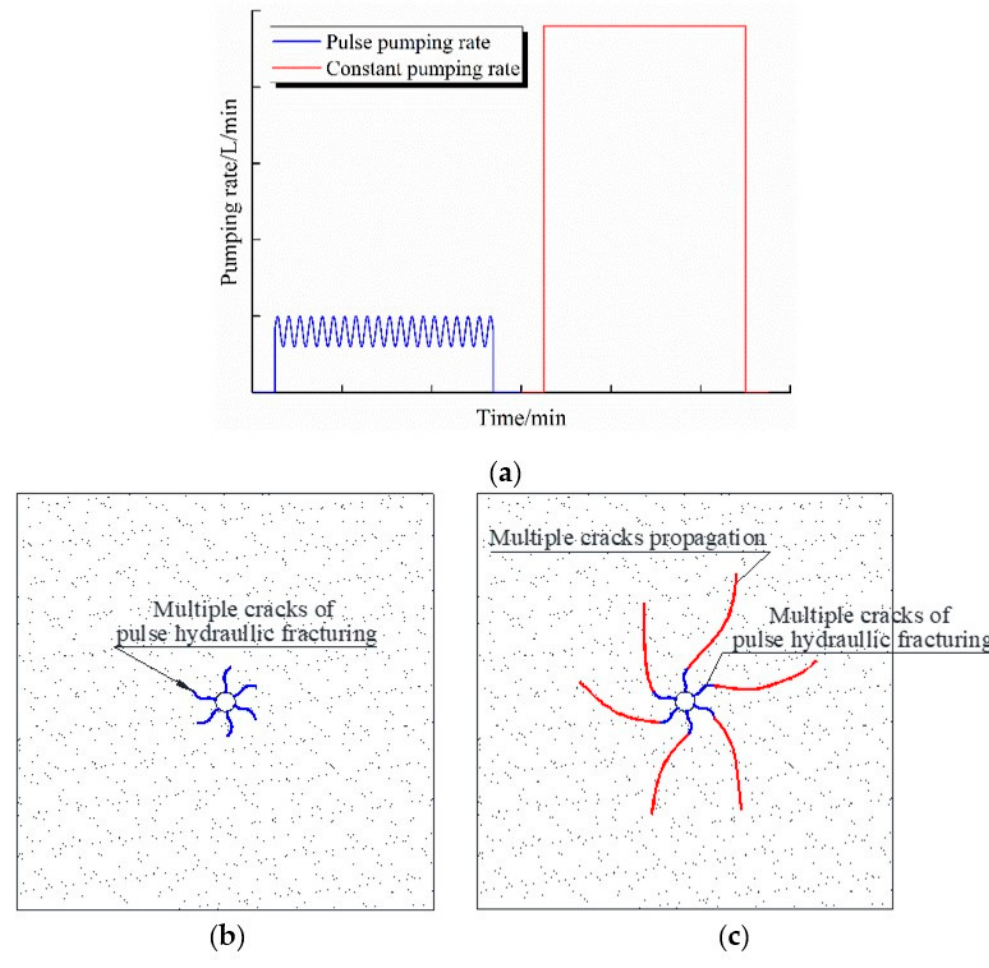
Figure 3. Schematic diagram of combining pre-pulse and constant pumping rate hydraulic fracturing: ( a ) pumping process, ( b ) pre-hydraulic fracturing with pulse pumping rate, and ( c ) hydraulic fracturing with constant pumping